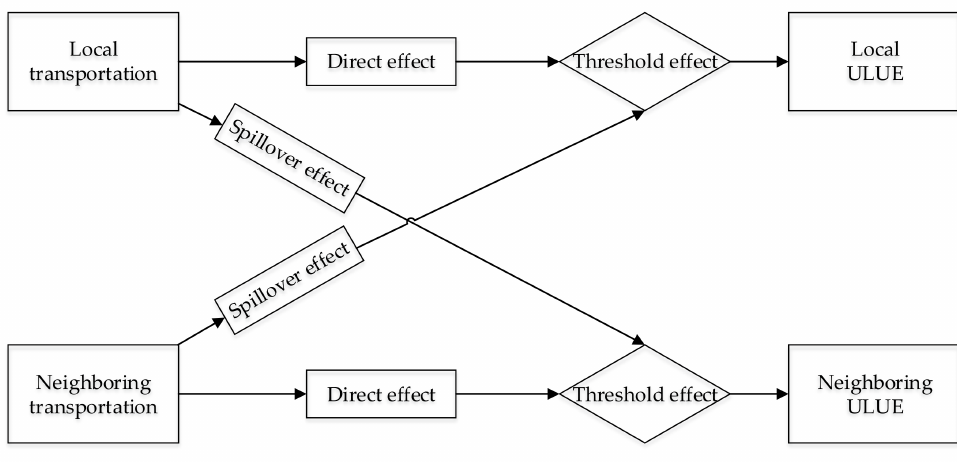
Figure 1. Diagram of the influencing mechanisms. ULUE, urban land use